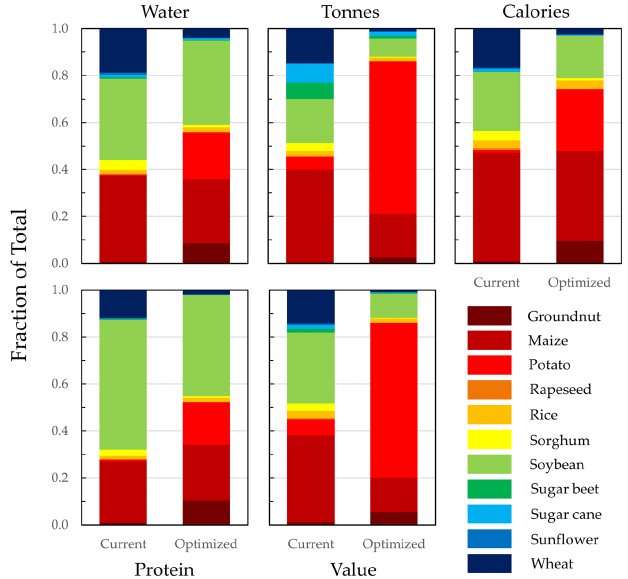
Figure 3. Relative contribution of crops to water demand, production, and economic value under current and optimized scenarios.